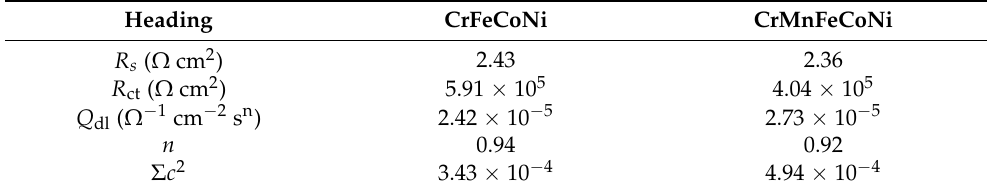
Table 3. EEC fitting parameters for electrochemical impedance spectra in 3.5 wt% NaCl solution under OCP